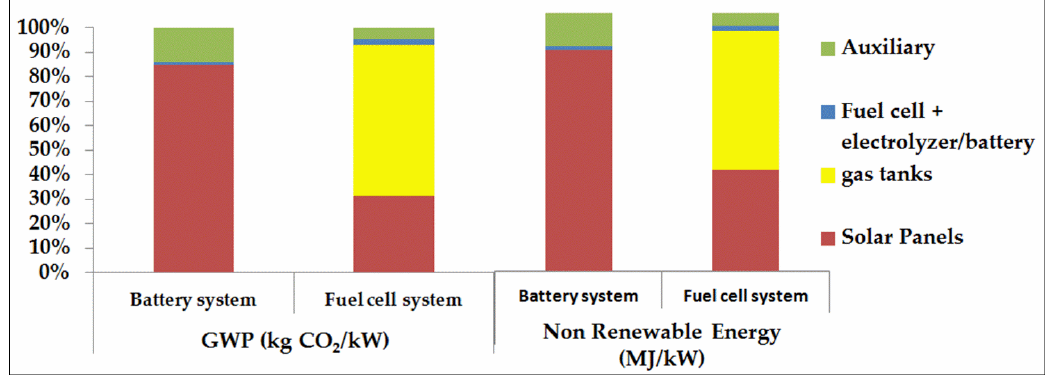
Figure 9. Impact distribution for the main components of the stationary systems for global warming potential and non-renewable energy.